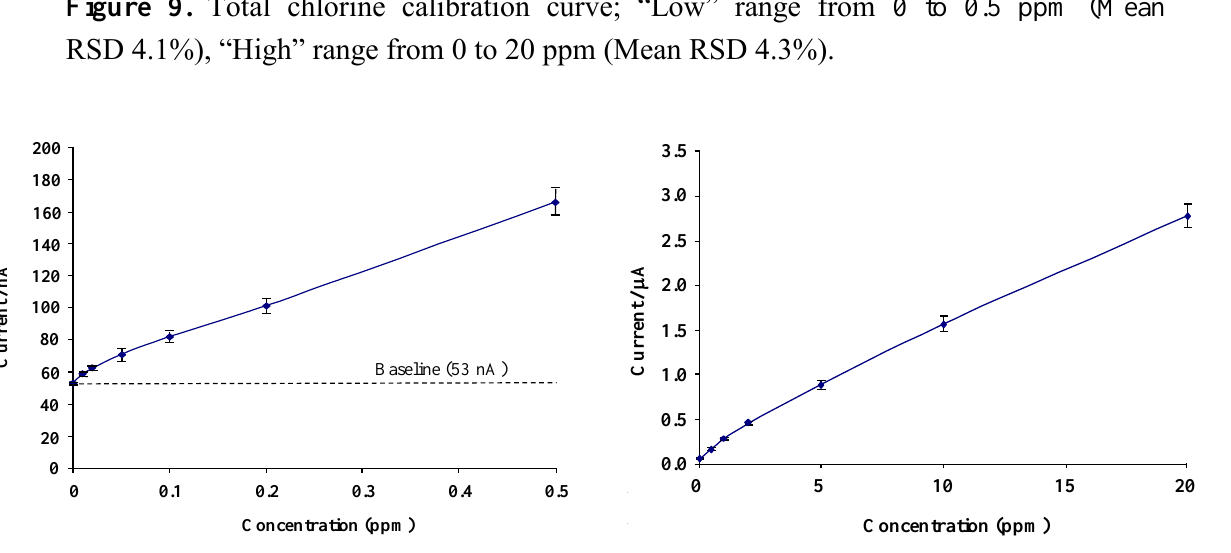
Figure 9. Total chlorine calibration curve; ―Low‖ range from 0 to 0.5 ppm (Mean RSD 4.1%), ―High‖ range from 0 to 20 ppm (Mean RSD